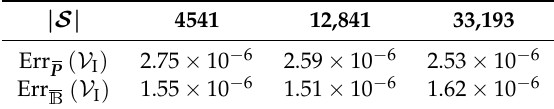
Table 2. Output error for different numbers of training parameters n s for a reduced basis of fixed size n u = 20 and n y =